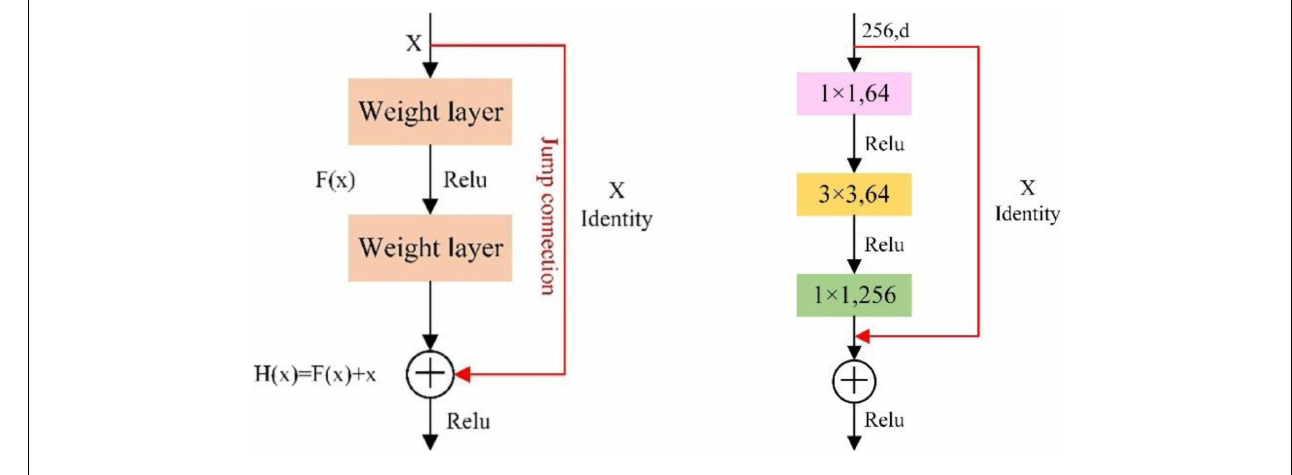
FIGURE 4 | The residual block (left) and the bottleneck structure (right) .